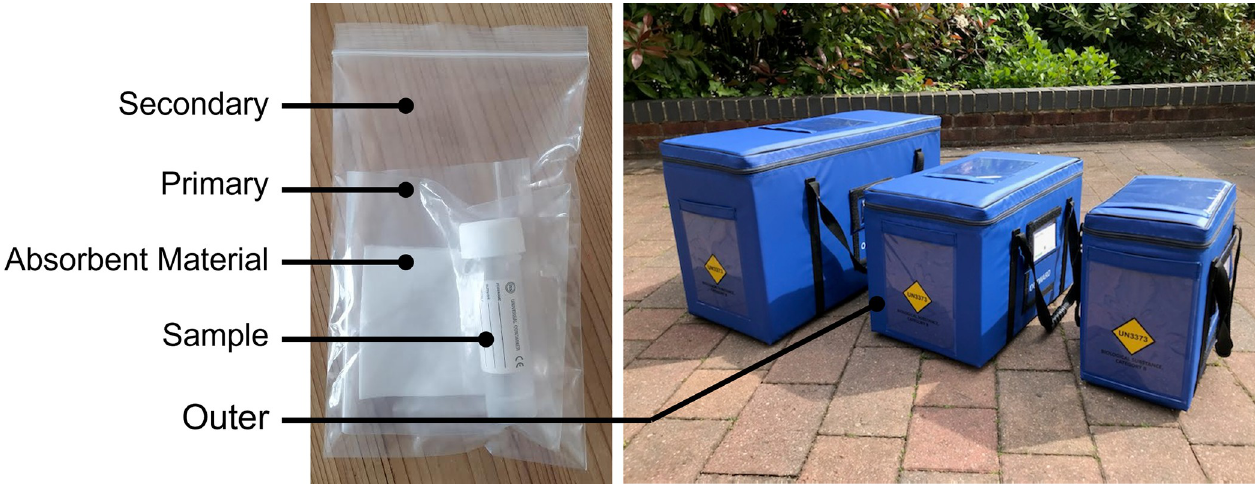
Fig 1. UN3373 PI650 compliant packaging. Left–sample, contained in leakproof primary and secondary packaging with absorbent material; right–Versapak insulated outer packaging (centre (‘medium’) = 460mm (w), 255mm (D), 305mm (H)).